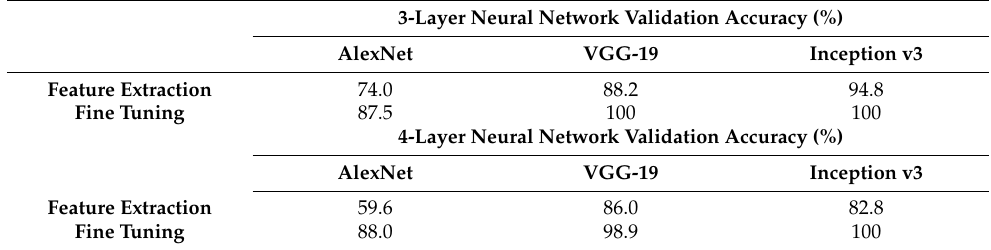
Table 7. Validation accuracy results of the three proposed DCNNs, trained with the PlantVillage dataset images, on the 20th training epoch for a 3-layer and a 4-layer FC DNN.